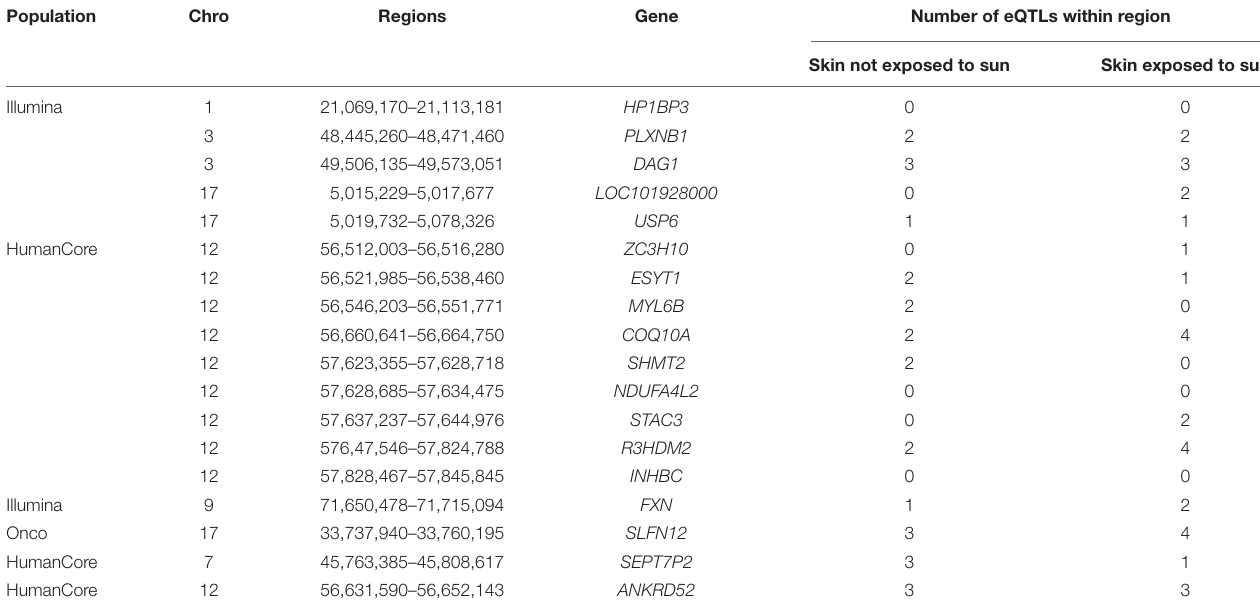
TABLE 8 | Number of eQTLs located within identified regions in skin tissues exposed or not exposed to sun. Population